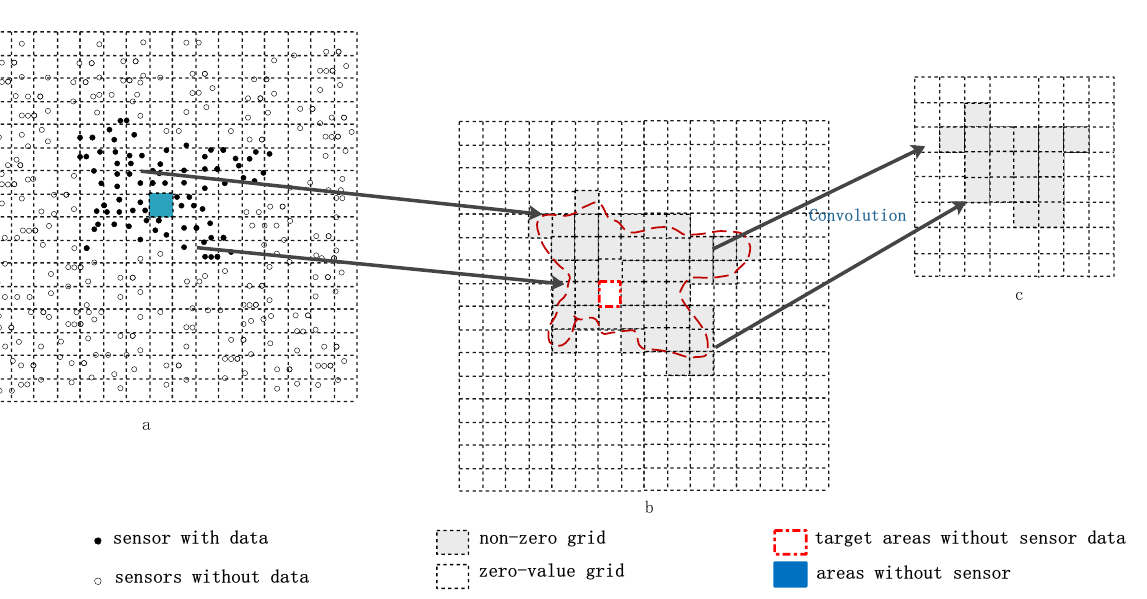
Figure 3. Fusion process of sensor data. ( a ) is the original network and the distribution of the sensors data; ( b ) is the marked SA including a special grid without sensor; ( c ) is the fusion result of the sensors